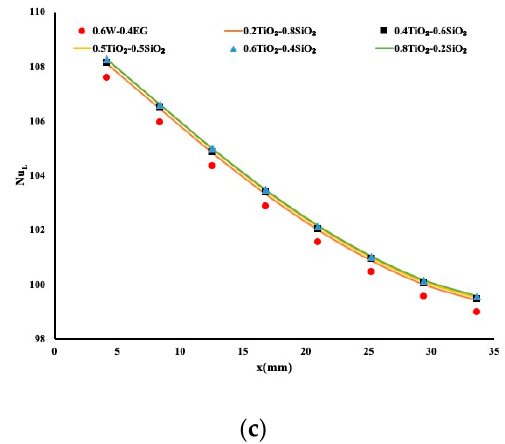
Figure 4. Heat enhancement using TiO 2 –SiO 2 in the ethylene glycol (EG)–water mixture. ( a ) Temperature variation along the flow, ( b ) Nusselt number of each individual mixture, ( c ) Nusselt number using standard definition.